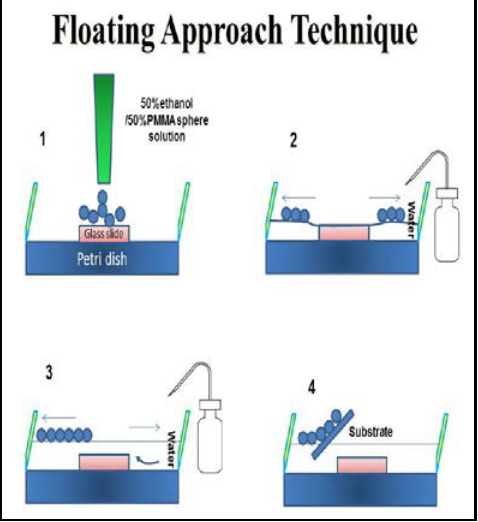
Fig.2: Floating approach